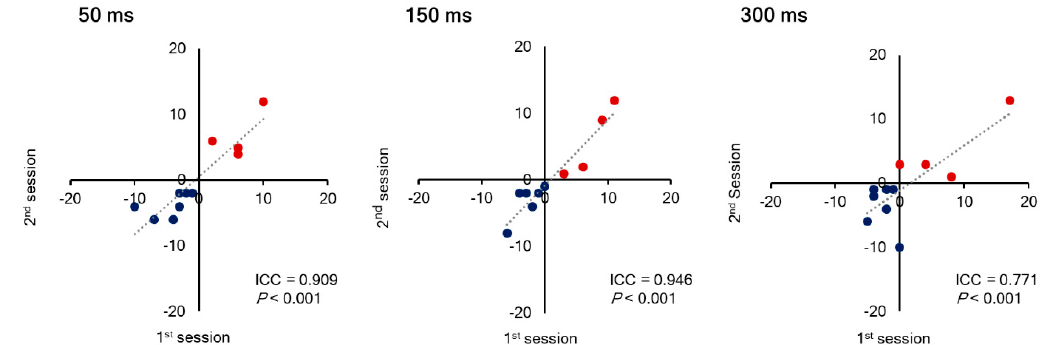
Figure 2. Relationship of line length judgement task score between 1st and 2nd preliminary sessions. The subjects plotted in the first quadrant show a rightward bias (red circles), and the subjects plotted in the third quadrant show a leftward bias (blue circles).